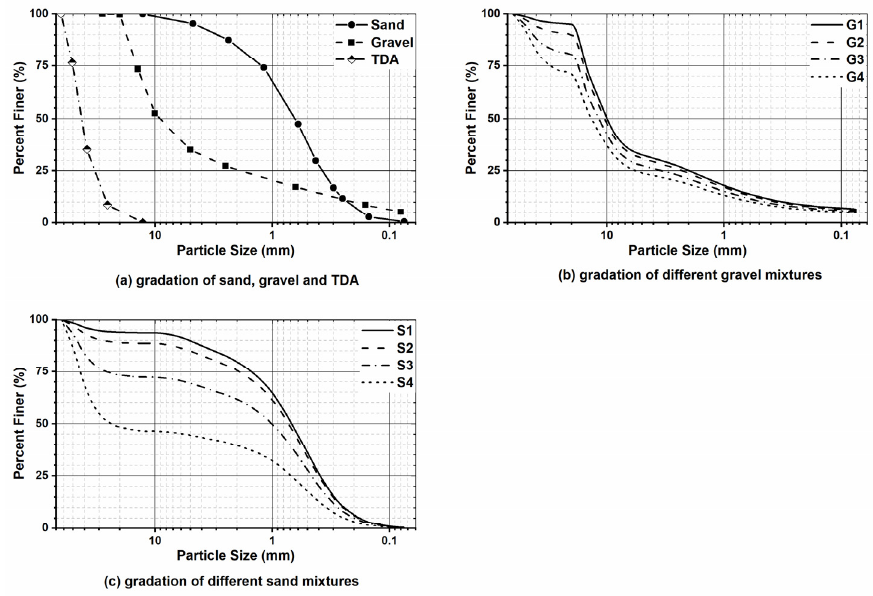
Figure 1. Particle size distributions of the samples